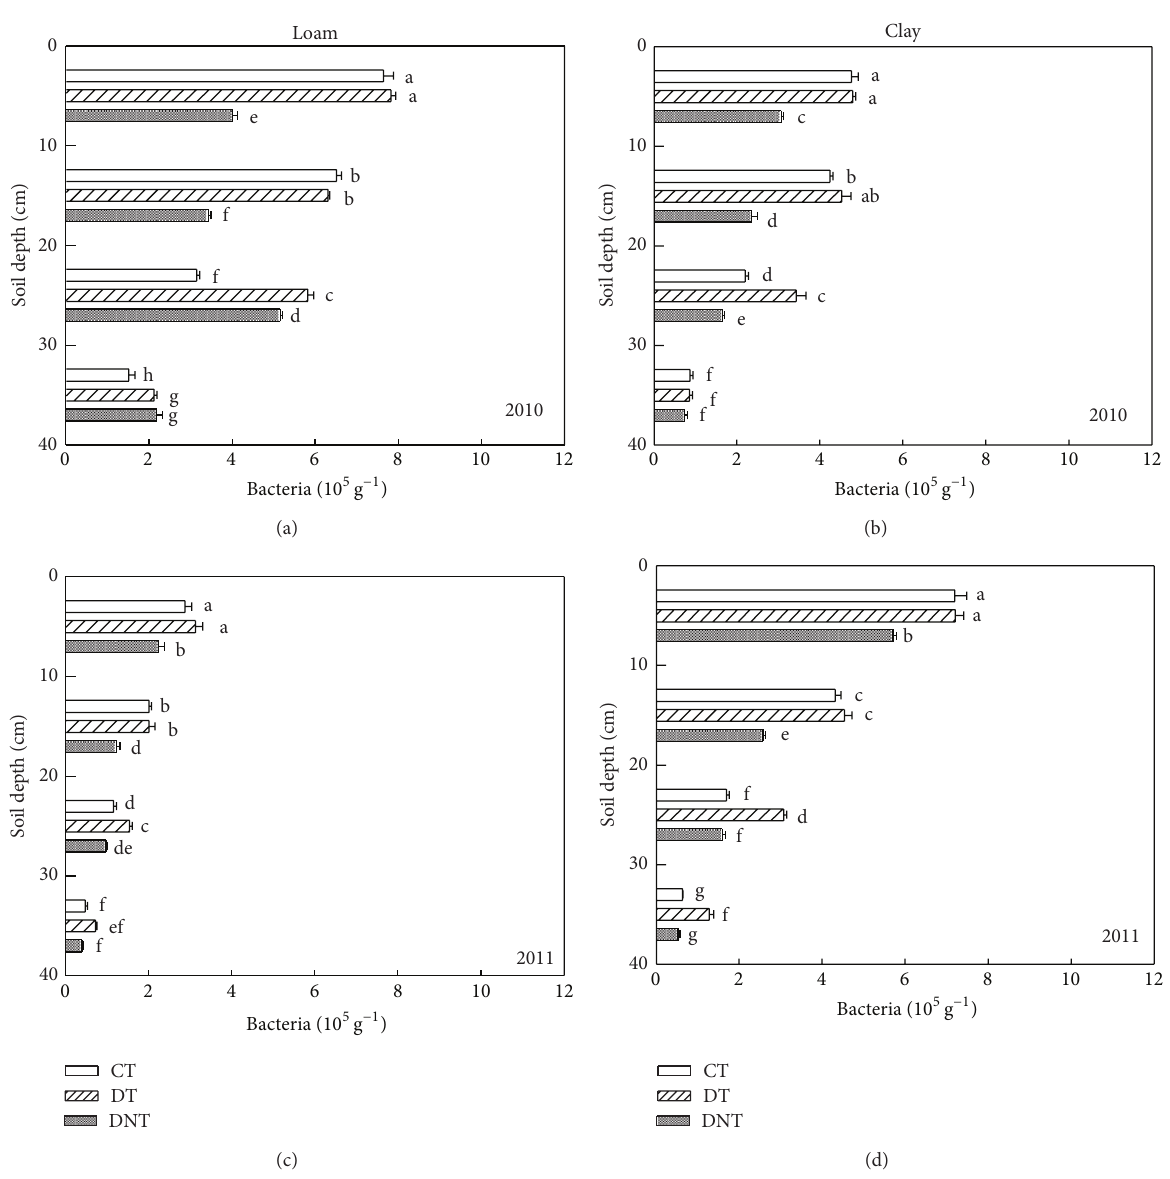
Figure 2: Effects of tillage and straw returning on the number of soil bacteria. Different small letters indicated significant difference at 𝑃 < 0.05 according to Duncan’s test. CT represented conventional tillage, moldboard ploughed to a depth of 20 cm, and straw was returned. DT represented deep tillage moldboard ploughed to a depth of 30 cm and straw was returned. DNT represented deep tillage moldboard ploughed to a depth of 30 cm and straw was